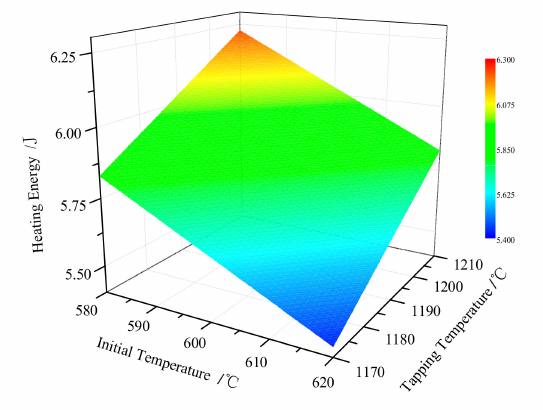
Figure 5. The influence of initial and tapping temperature on heating energy.